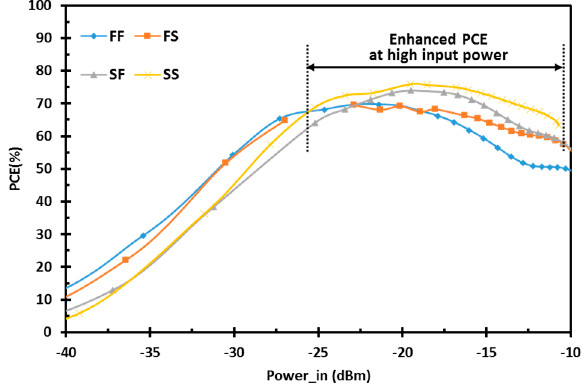
Figure 14. Post-layout simulation results of the PCE vs. input RF power at different process corners.